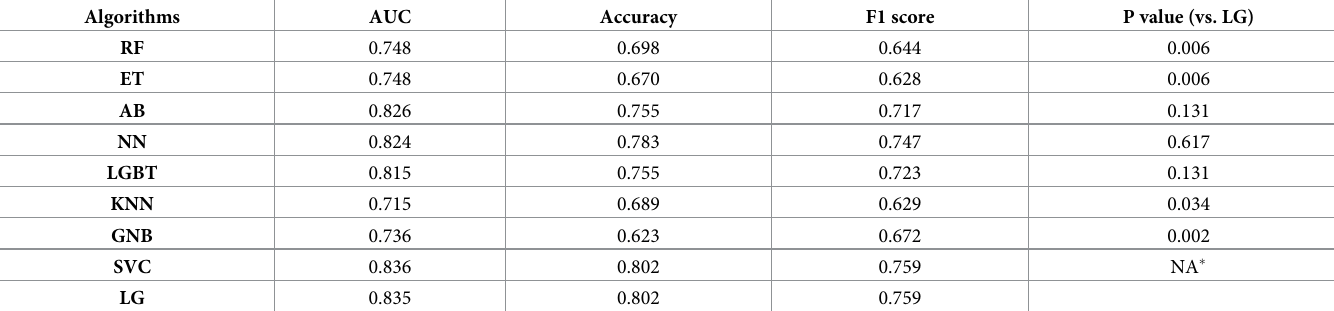
Table 3. AUC, accuracy and F1 score for different machine learning algorithms tested in the Easton cohort. Algorithms